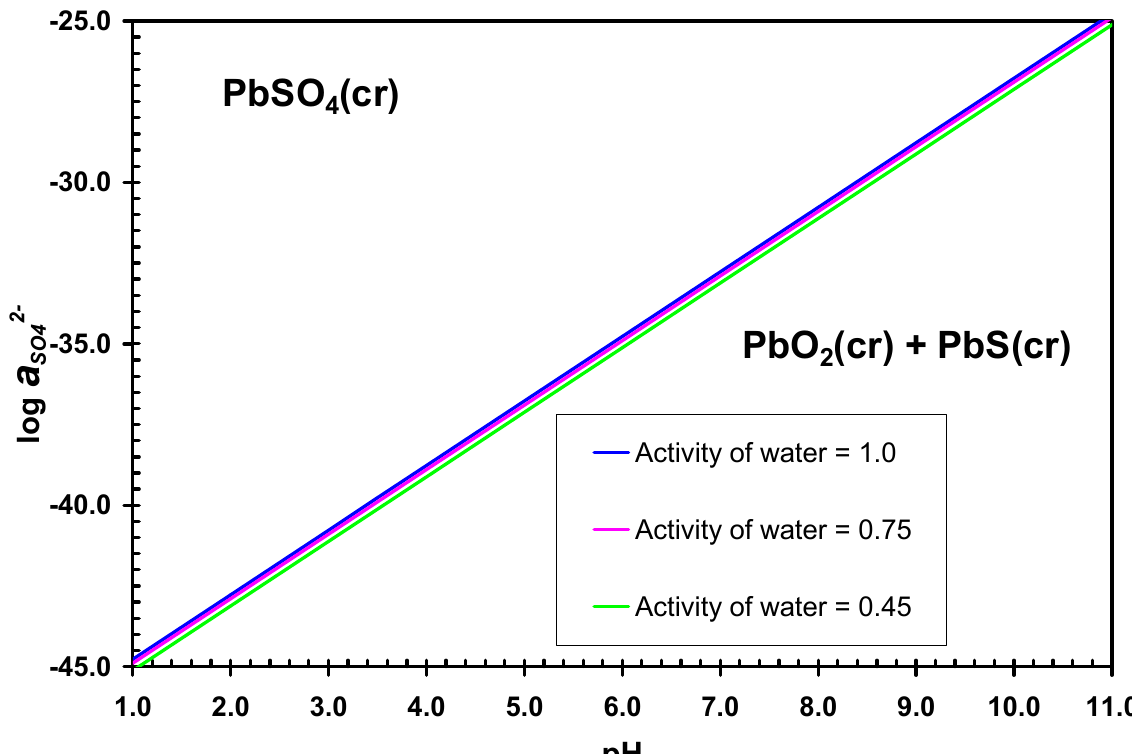
Figure 6. The stability fields of the assemblage of lead dioxide [PbO 2 (cr)] + lead sulfide [PbS(cr)] with respect to lead sulfate [PbSO 4 (cr)] at 25 ◦ C in the space of pH versus log a bearing solution for reduction of lead dioxide in lead pastes at water activities of 1.0, 0.75, and 0.45, respectively.